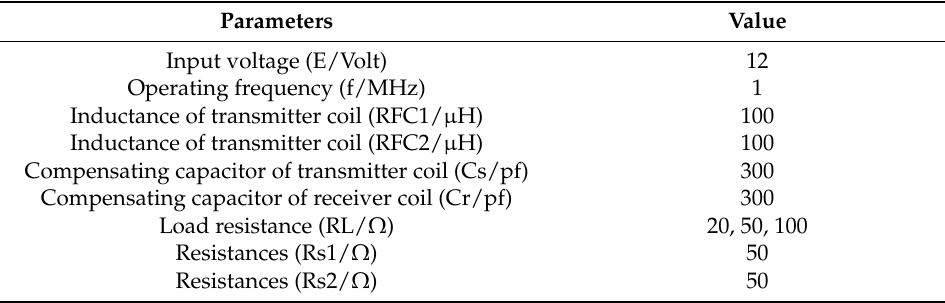
Table 1. Single-tube loop coil (STLC) Parameters.